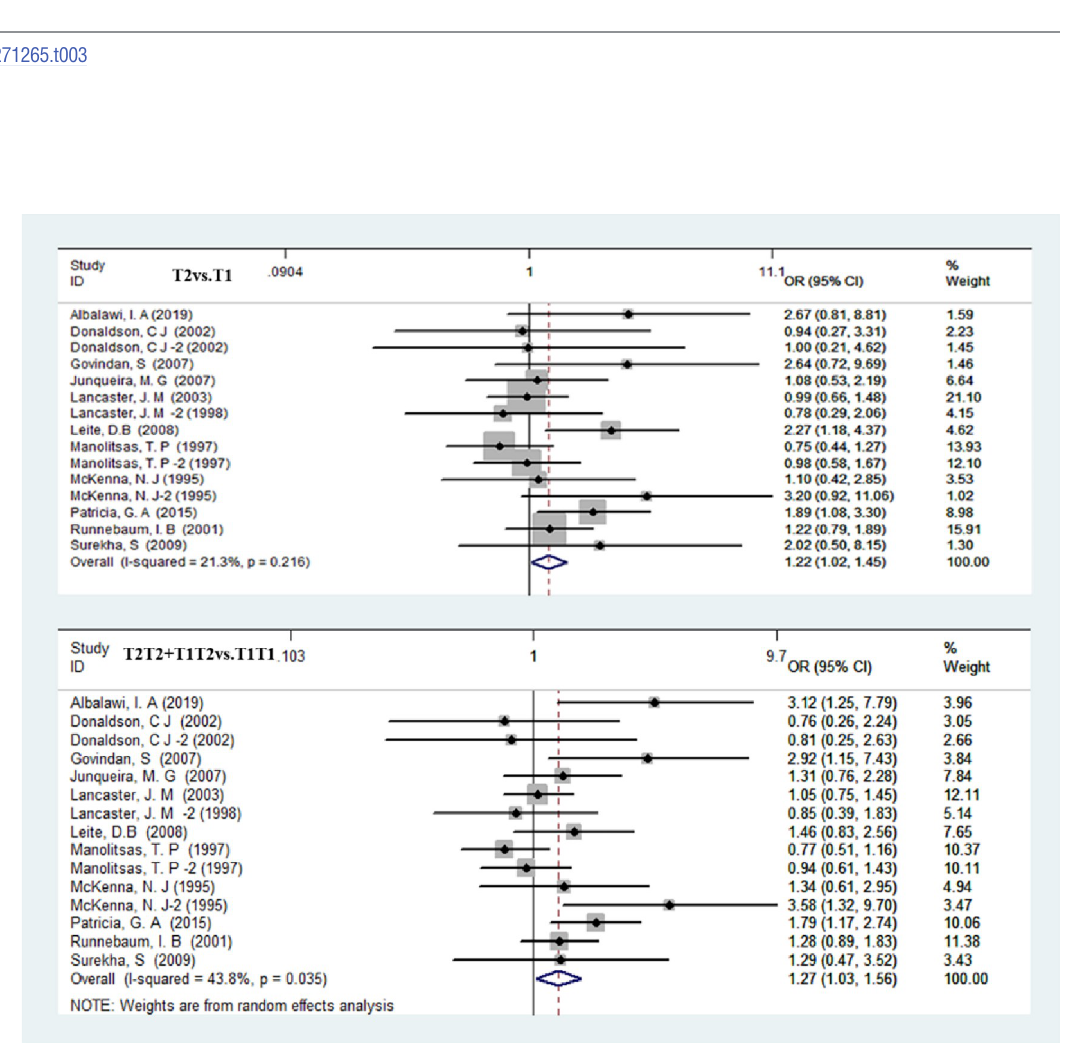
Fig 2. Forest plot of overall cancer risk associated with Alu-insertion PgR polymorphism (T2 vs. T1 and T2T2+T1T2vs.